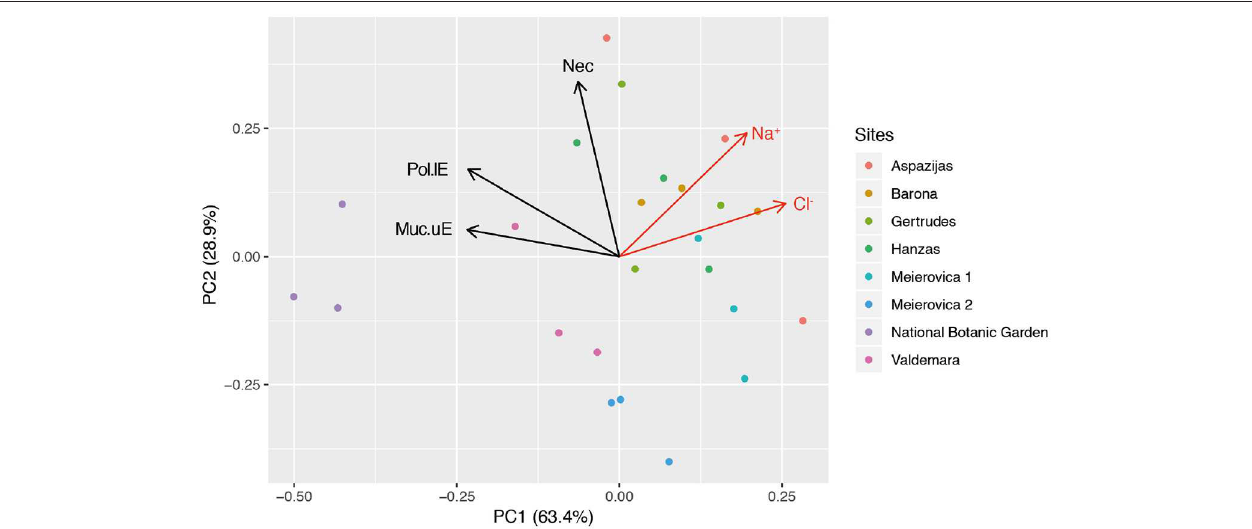
FIGURE 3 | Unconstrained ordination (PCA) of structural parameters indicative of biotic injury (Muc_lE, Muc_uE, Nec_lE) in the plane formed by the first and second principal components. Na/Cl contamination within lime tree foliage at the research sites: (i) uncontaminated, below 98/940 ppm, NBG; (ii) moderate, contamination range 118–3,100/3,000–7,570 ppm, Valdemara, Meierovica 2; (iii) severe, contamination range 2,660–6,600/5,000–11,500 ppm, Barona, Meierovica 1; (iv) very high, contamination range 5,400–13,600/5,250–16,750 ppm, Gertrudes, Hanzas, Aspazijas. Abbreviations for the descriptor variables: Muc_lE/uE percentage length of lower/upper epidermis filled with mucilages, Nec_lE percentage length of lower epidermis showing necrosis, n = 3 tress per